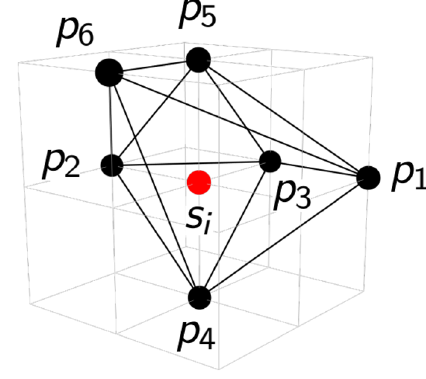
Figure 29 . Toric diagram for Model